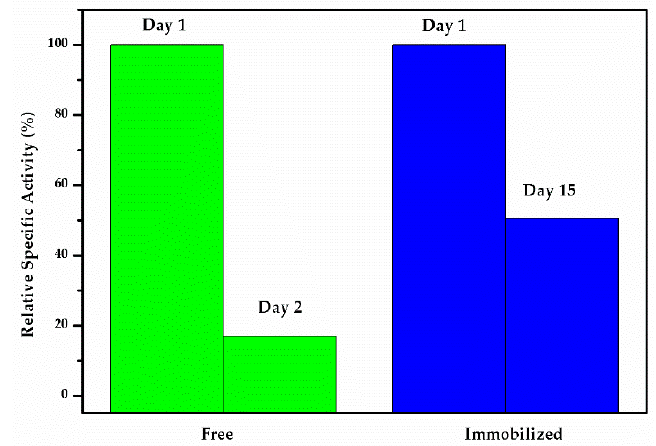
Figure 8. Storage stability: relative specific activity of free GAD on first two days and of immobilized GAD on 1st and 15th day.